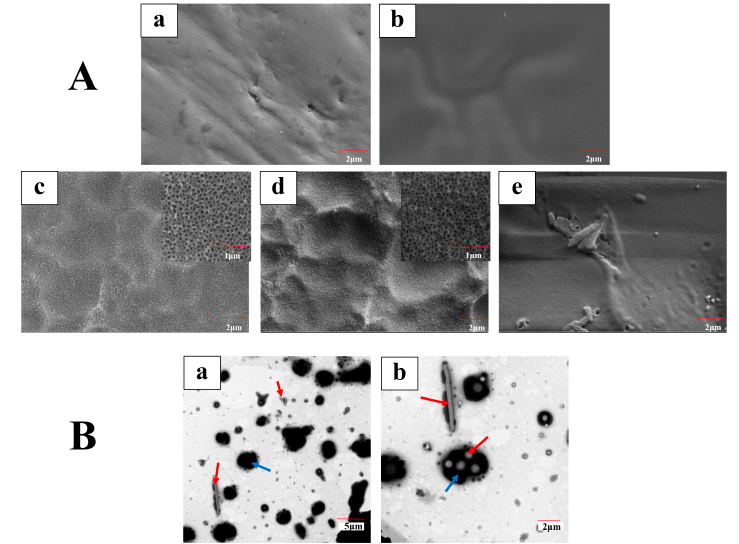
Figure 2. ( A ) Scanning electron microscopy (SEM) images. Images of di ff erent surfaces by SEM observed at 5000 × scale bar, 2 µ m: ( a ) Ti; ( b ), Ti-PLGA; ( c ) NT, TiO 2 nanotubes; ( d ) NT-ICA, TiO 2 nanotubes loading icariin; ( e ) NT-ICA-PLGA, icariin-functionalized coating on TiO 2 nanotubes surface. Bar indicate 1 µ m in magnified insets of ( c , d ). ( B ) Images of icariin with poly lactic-co-glycolic acid (PLGA) by transmission electron microscopy (TEM): ( a ) image observed at 1000 × scale bar, 5 µ m; ( b ) image observed at 2000 × , scale bar, 2 µ m. The red arrows denote icariin. The blue arrows denote PLGA. The representative images from three independent experiments were